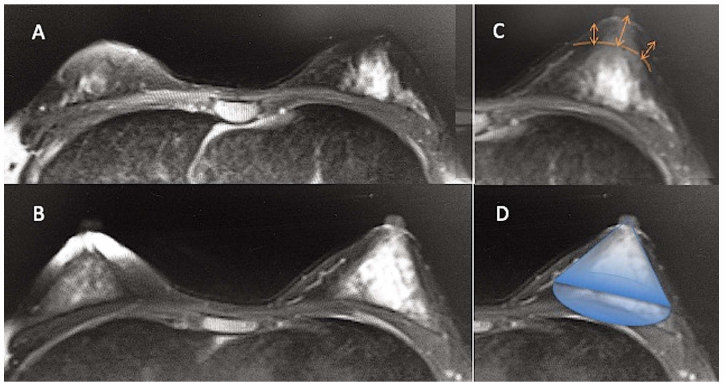
Figure 4. Magnetic resonance imaging (MRI) of a patient treated with AFG. ( A ) The pre-operative situation in a patient affected by bilateral breast hypoplasia. ( B ) The post-operative situation at T5 (6 months) after one AFG treatment with an evident improvement of bilateral breast volume. ( C ) Overlapping of pre-and post-op MRI images with the volume increase measurement detail of 29.5 mm (arrows). ( D ) Overlapping of a geometric cone on augmented breast to note the similar aspect of the breast to a